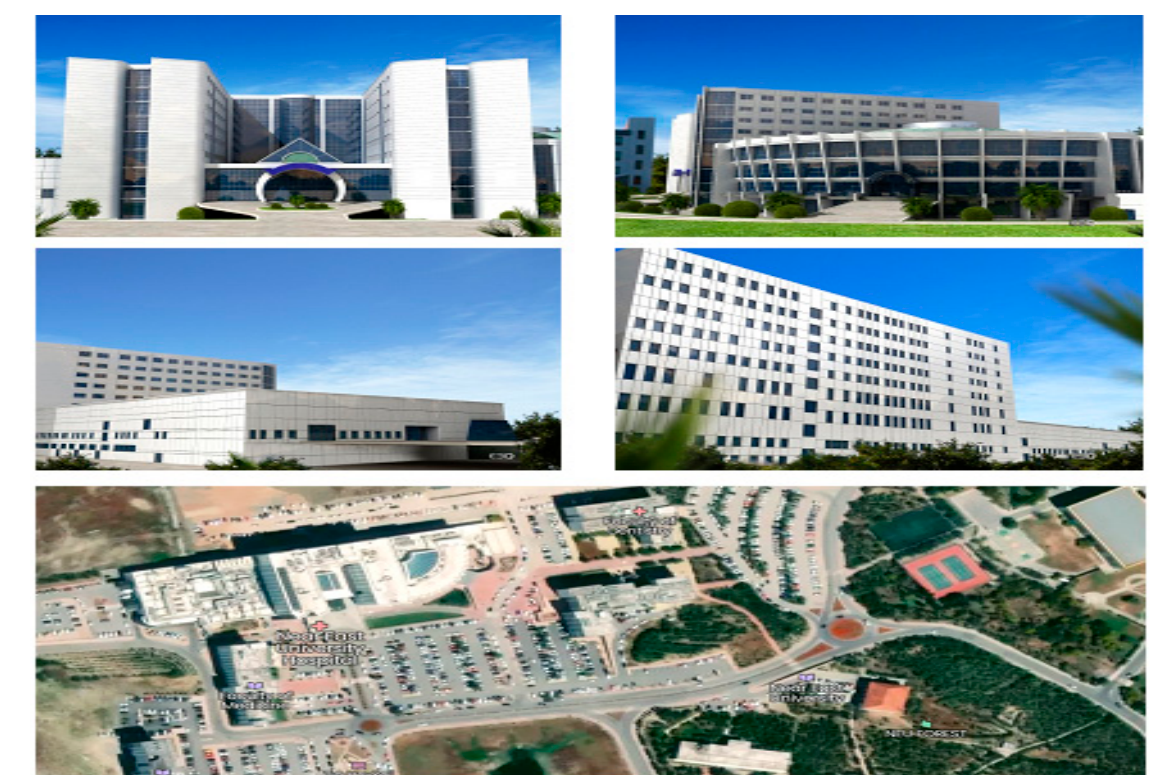
Figure 2. Panoramic view of Near East University Hospital.